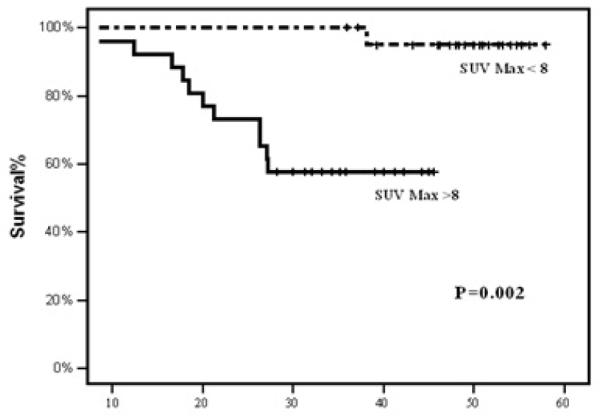
Disease free Survival (DFS) in months according to primary treatment FDG PET-CT maximal standard uptake value (SUVmax).